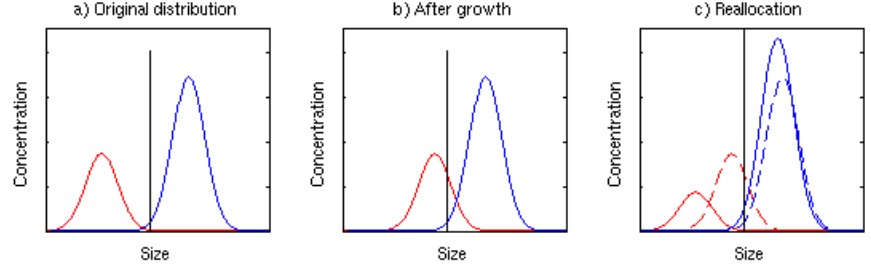
Fig. 1. Schematic figure illustrating the growth of a mode over its threshold diameter, which leads to reallocation of the mode and to a decrease in its mean diameter and total number concentration. The solid vertical line denotes the threshold diameter. At (c) the dashed line corresponds to the size distribution after growth (solid line in b)).